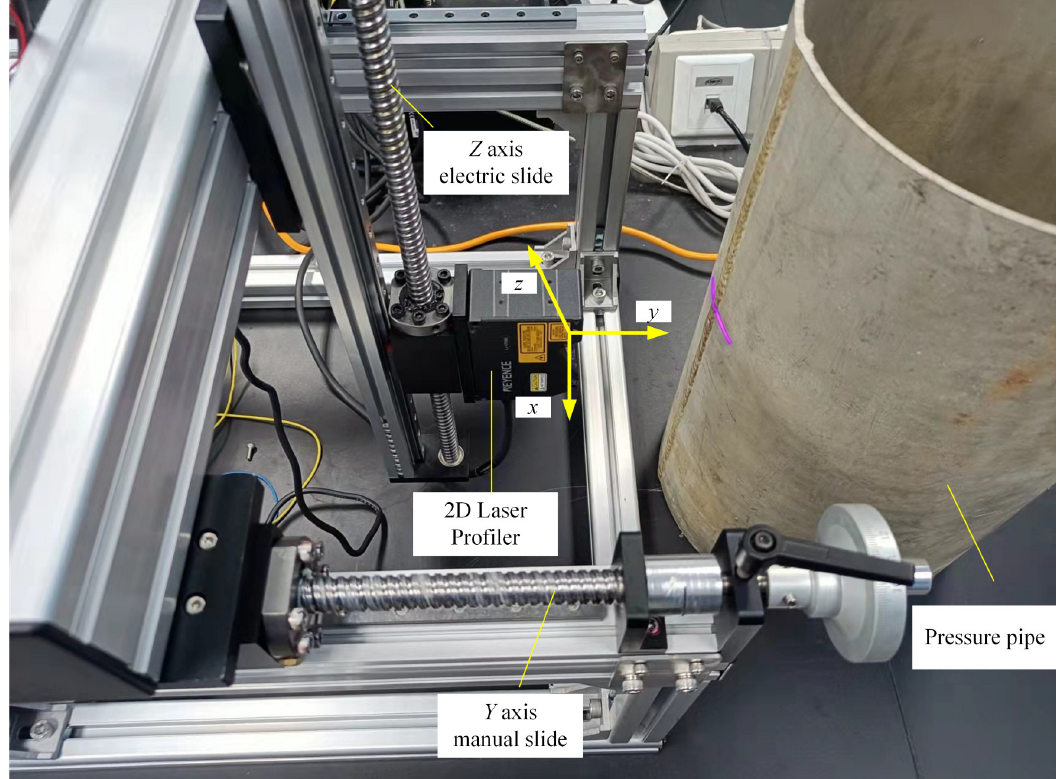
Fig 1. Device for measuring weld surface parameters, which consists of a laser profile sensor, electric slide-in Z-axis, manual slide in Y-axis, and computer.